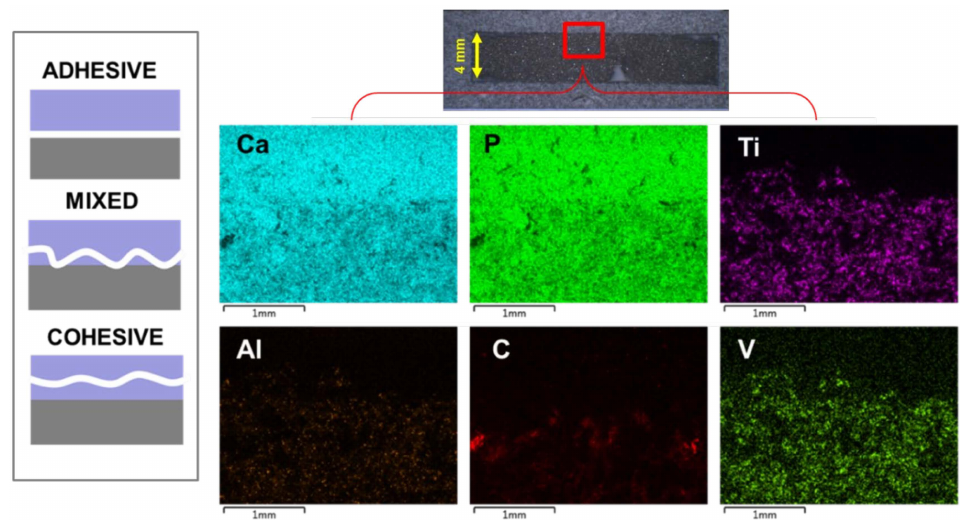
Figure 11. Breaking types and an example of SC coating mixed rupture by EDX